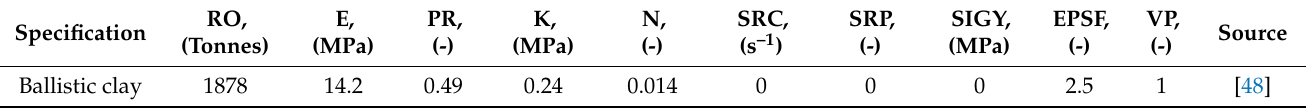
Table 3. Parameters of the *MAT_018- POWER_LAW_PLASTICITY model for ballistic